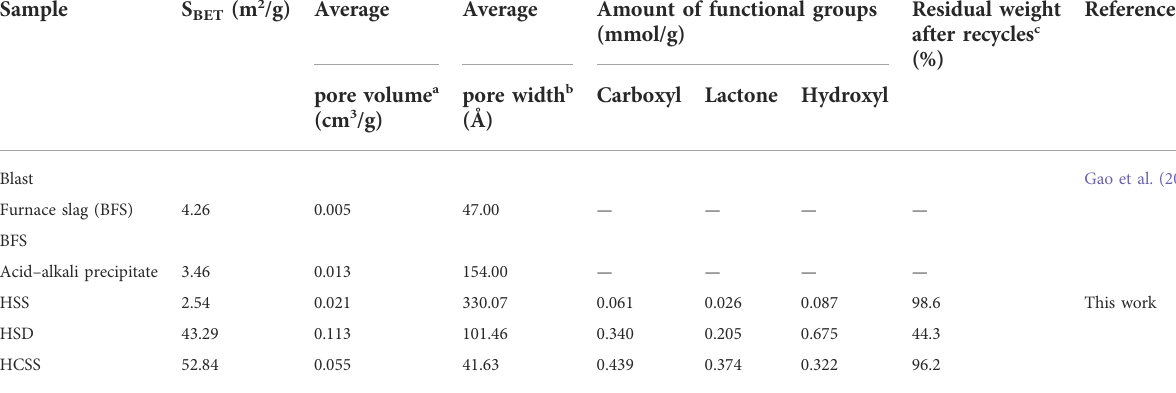
TABLE 2 Comparison of the number of surface parameters, functional groups, and residual weight of HSS, HSD, and HCSS with other adsorbents. Sample S BET (m 2 /g)